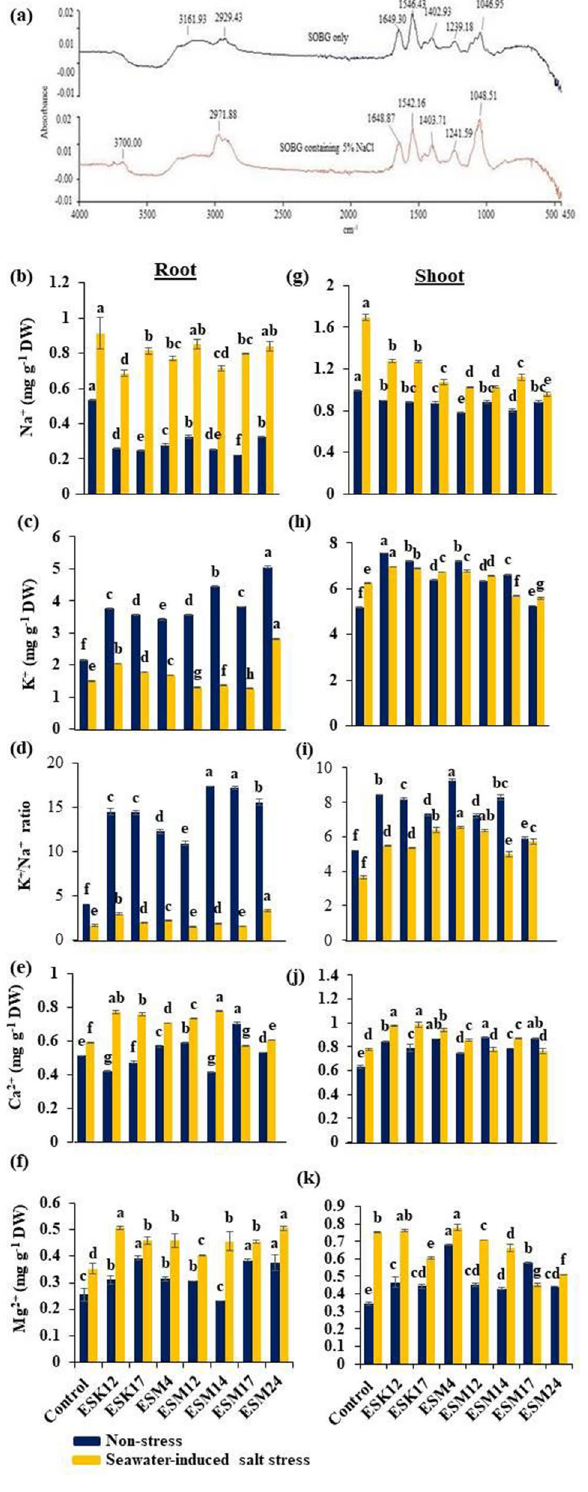
Figure 8. Shifting of peak positions in the biofilm biomass of L. adecarboxylata ESK12 after growth in SOBG containing 5% NaCl (lower lane) as compared to standard SOBG (upper lane) ( a ). Effects of the inoculation of halotolerant biofilm-producing rhizobacteria on ionic balance in roots and shoots of tomato plants. Pot-grown tomato plants were inoculated with different bacterial isolates. Na + , K + , K + /Na + , Ca 2+ , and Mg 2+ were measured in the roots ( b–f ) (left) and shoots ( g–k ) (right). Blue and orange bars in the graphs represent the non-stress and seawater-induced salt stress. Values [mean ± standard error (SE)] of each treatment were attained from three biological replications ( n = 3). Different letters represent statistically significant different data to Fisher’s least significant difference (LSD) ( P < 0.001). DW dry